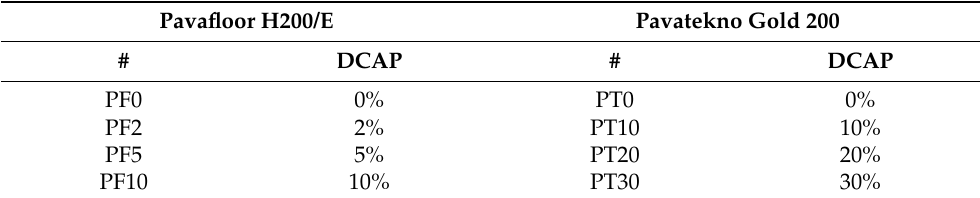
Table 1. Name (#) and DCAP content (wt%) of the samples studied in this work. Pavafloor H200/E Pavatekno Gold 200 # DCAP # DCAP PF0 0% PT0 PF2 PF5 5% PT20 20% PF10